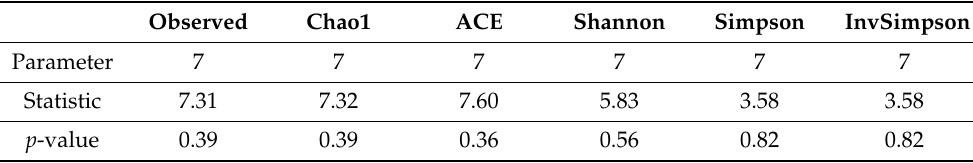
Figure 7. Heat tree of microbiome community structure found in L. pulmonaria samples. Size and color of nodes and edges show their abundance in the microbial community. Table 1. Heteroscedasticity in diversity estimates for the bacterial dataset, as assessed with Kruskal– Wallis rank sum